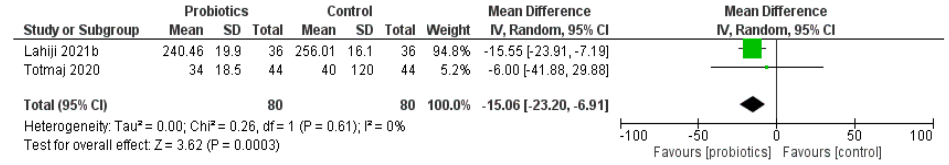
Figure 6. Meta-analysis for waist circumference (WC) ( A ) and WC by probiotics type ( B ).